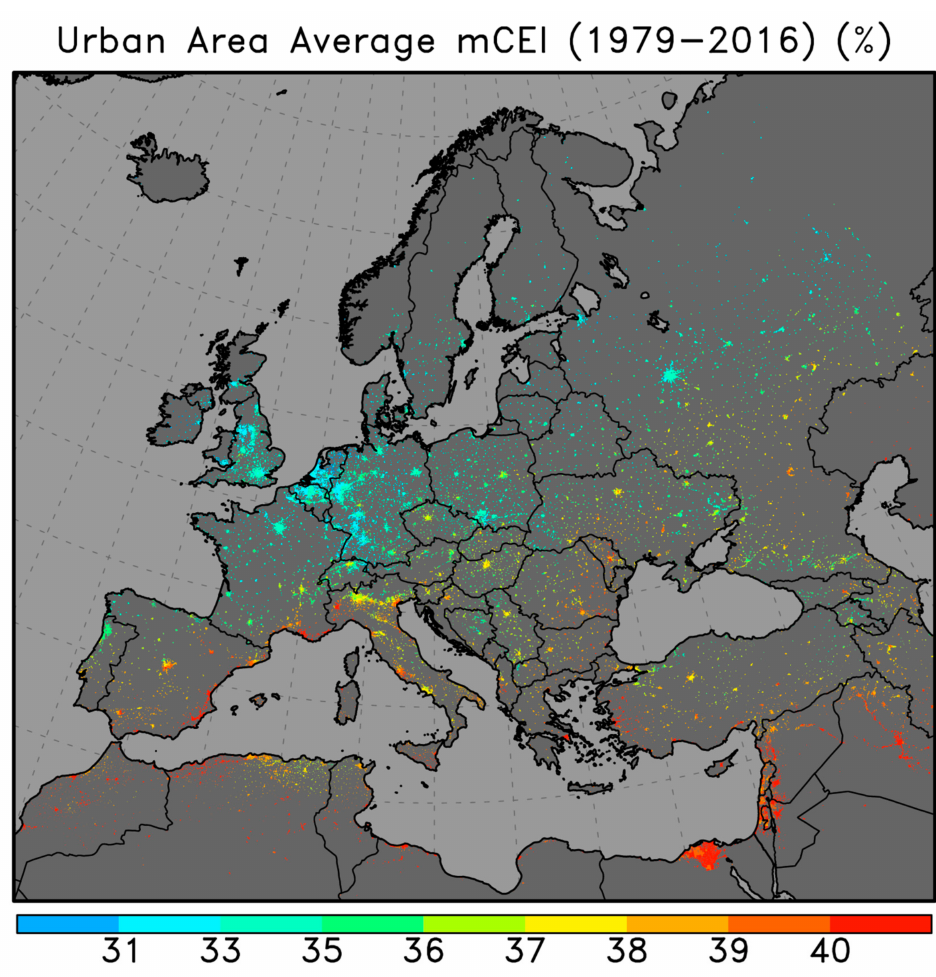
Figure 13. mCEI climatology over the urban settlements of the EURO–MED region.